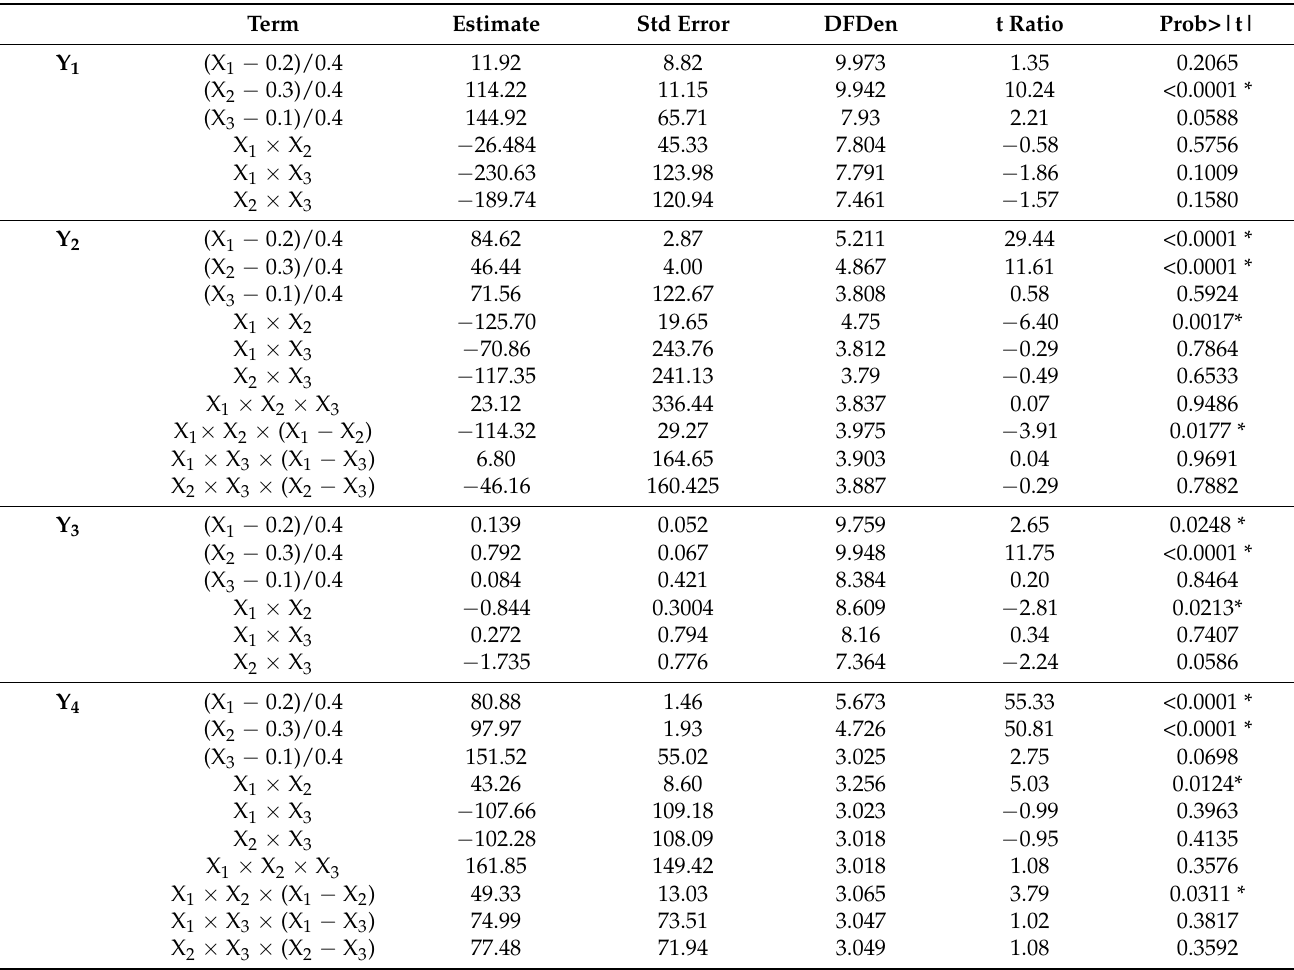
Table 4. Summary of ANOVA for the response